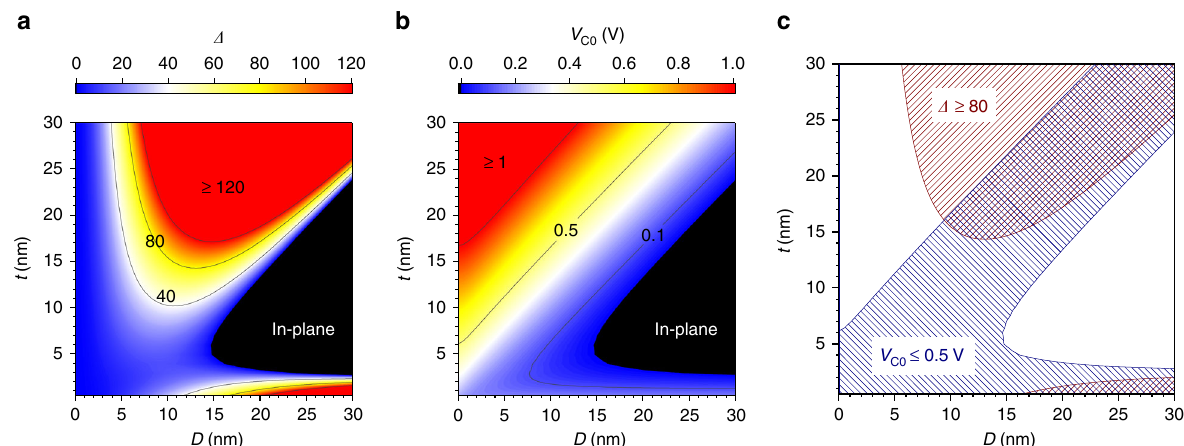
Fig. 1 Calculation on MTJ performances. a Thermal stability factor Δ as a function of thickness t and diameter D . b Intrinsic critical voltage V C0 based on the Slonczewski model, where resistance-area product RA = 1 Ω μ m 2 is assumed. c Regions satisfying Δ ≥ 80 (red-hatched) and V C0 ≤ 0.5 V